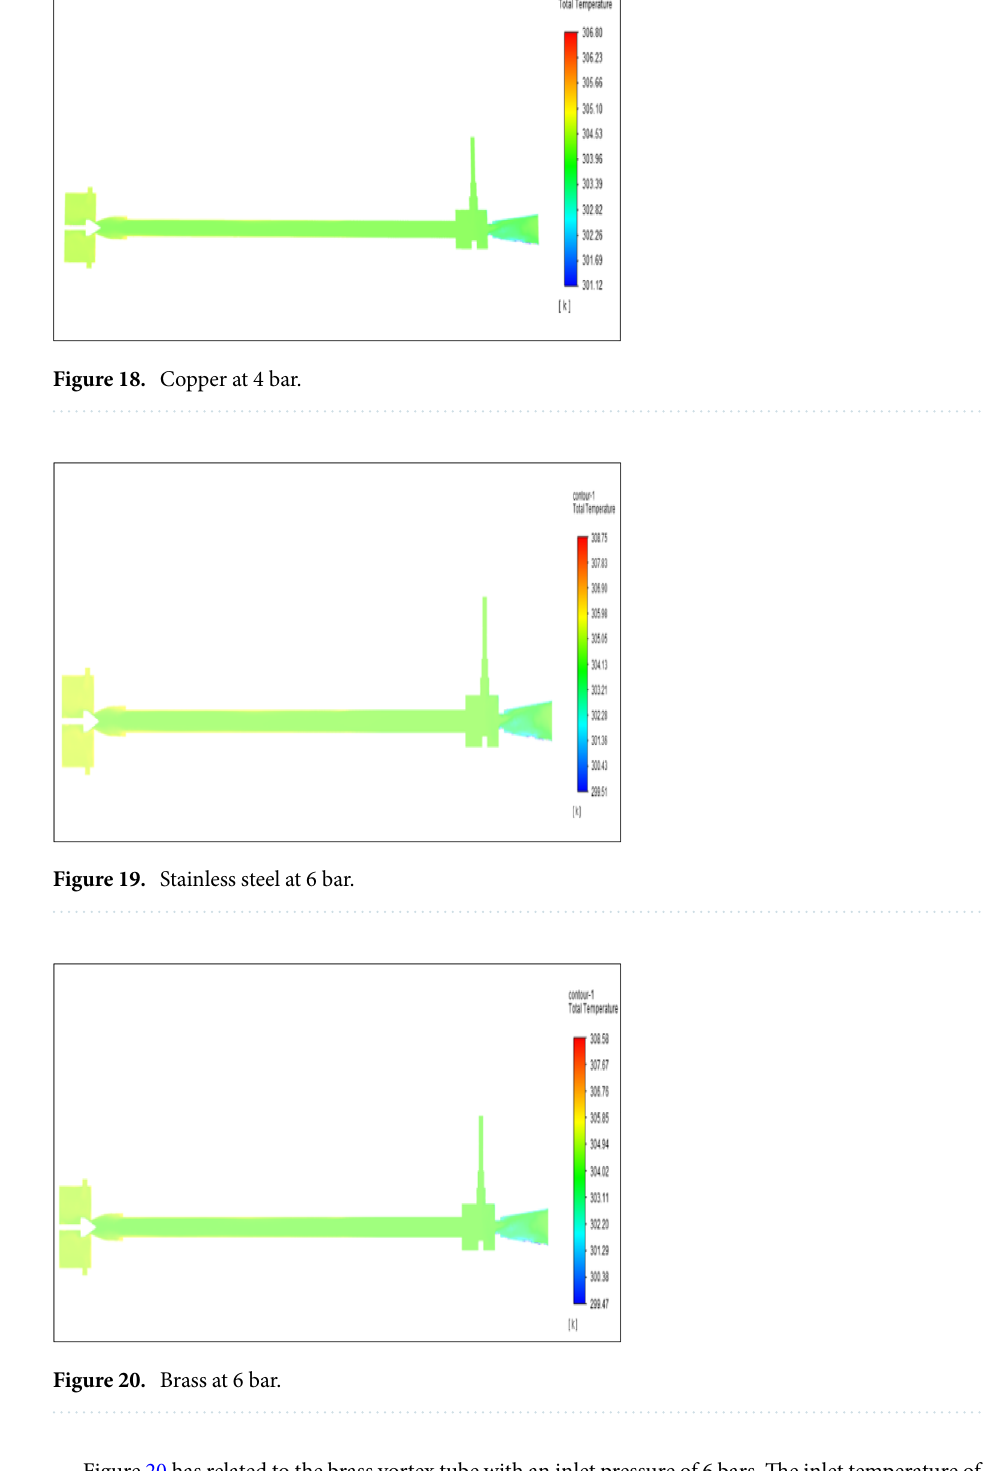
Figure 20 has related to the brass vortex tube with an inlet pressure of 6 bars. The inlet temperature of the VT is 303 K. The hot air temperature was obtained at the hot end as 307.62 K at the cold end side obtained a value of 300.19 K. The maximum temperature difference was found to be 7.43 K. Figure 21 has represented to PVC vortex tube with an inlet pressure of 6 bars. The inlet temperature of the VT is 303 K. The hot air temperature was obtained at the hot end as 306.04 K. Similarly at the cold end side obtained a value as 300.60 K. The maximum temperature difference was noticed as 6.03 K.